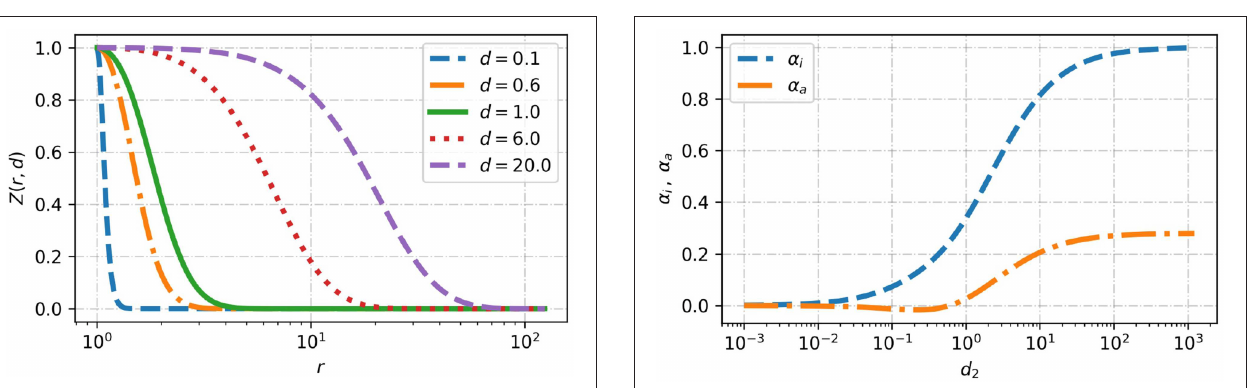
FIGURE 4 | Dimensionless drag force due to a solely monopole contribution, α i (see Equation 27), and solely due to quadrupole contribution, α a (see Equation 29), as a function of the dimensionless decay length, d 2 .